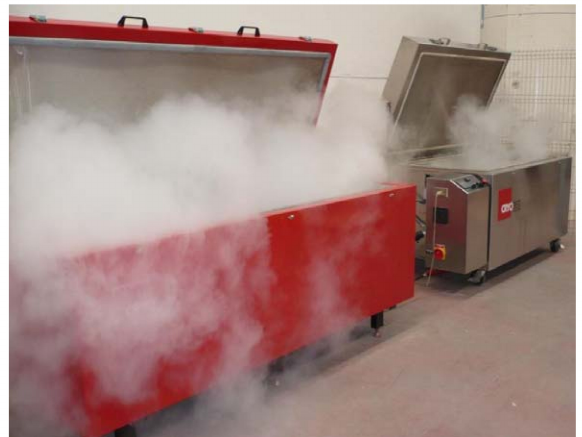
Figure 5. Cryogenic processors in IK4-Azterlan.